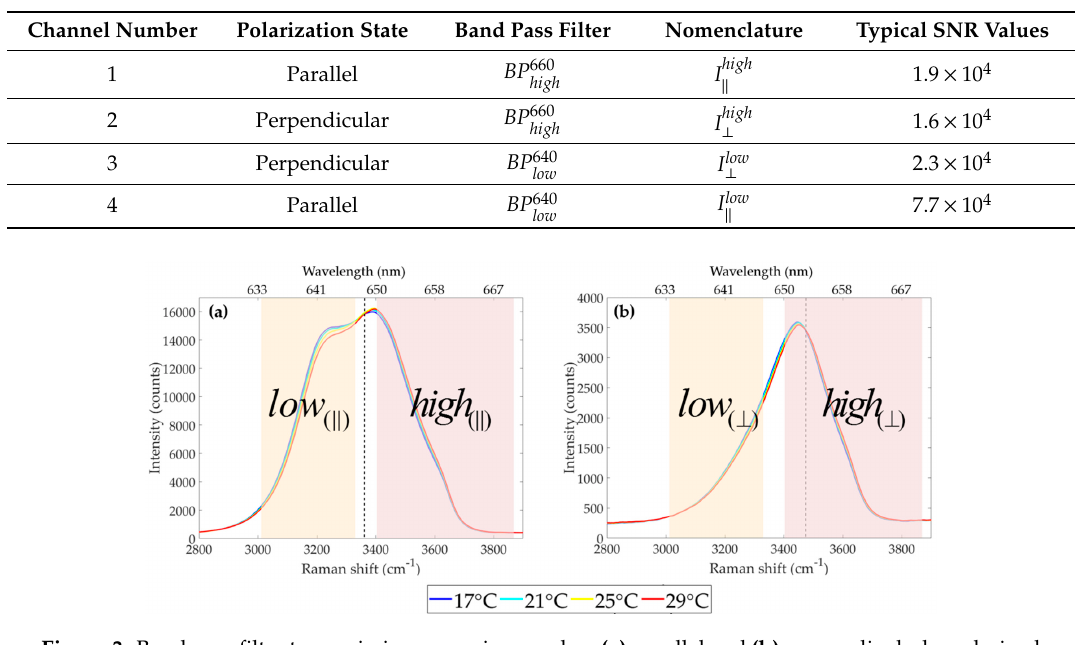
Figure 2. Experiment setup. Table 1. Nomenclature adopted for each spectral channel.